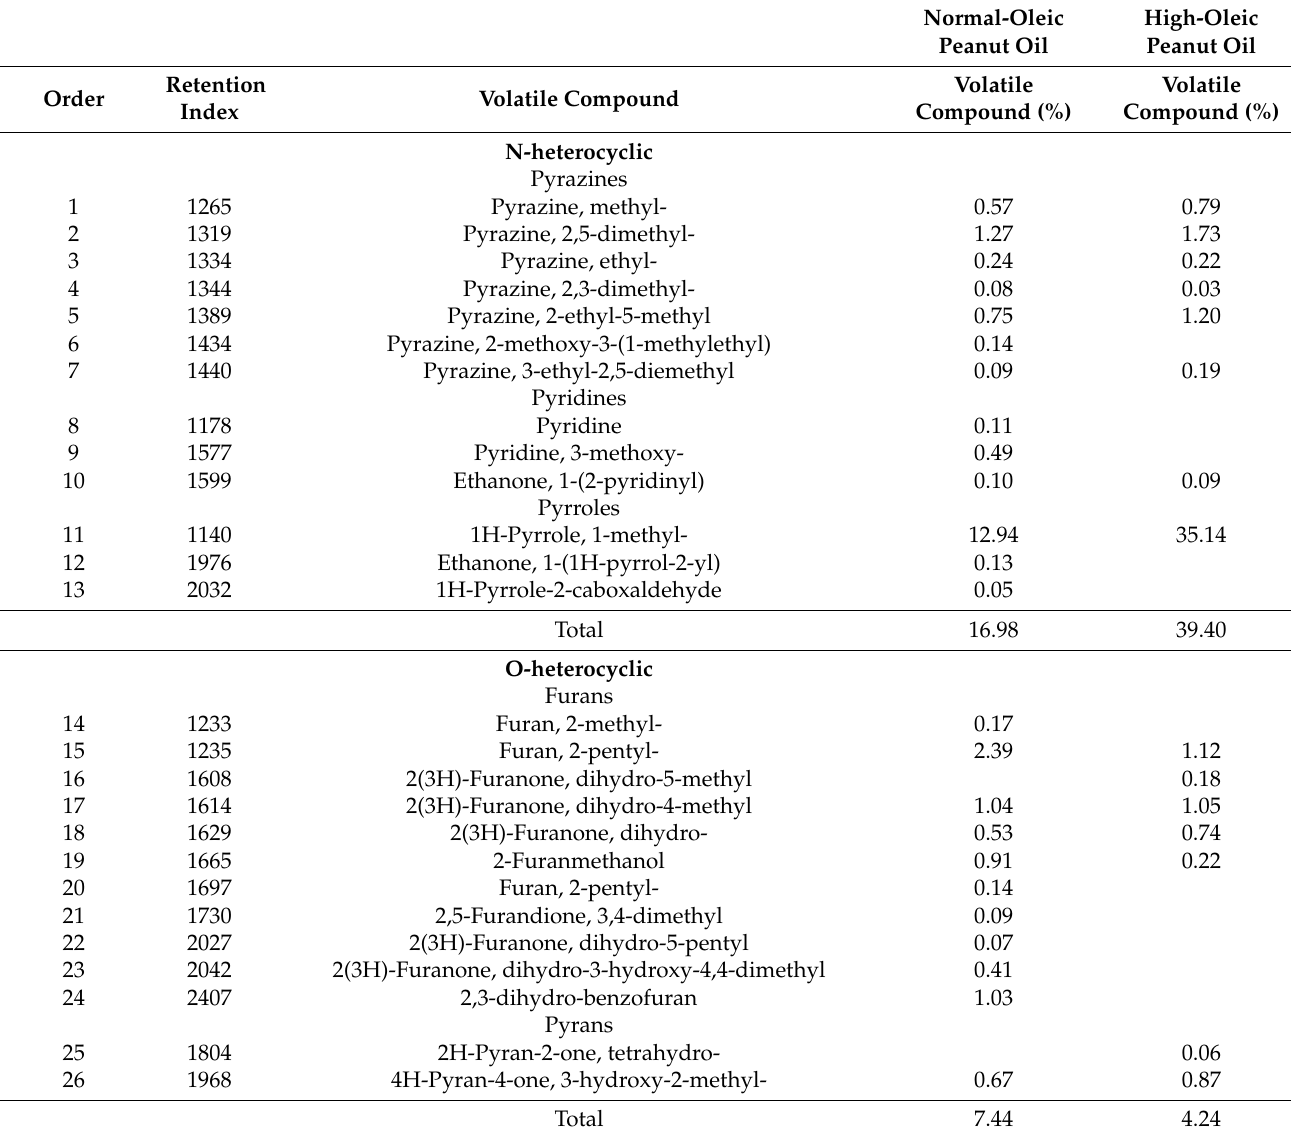
Table 2. Composition and relative content of volatile components in normal- and high-oleic peanut